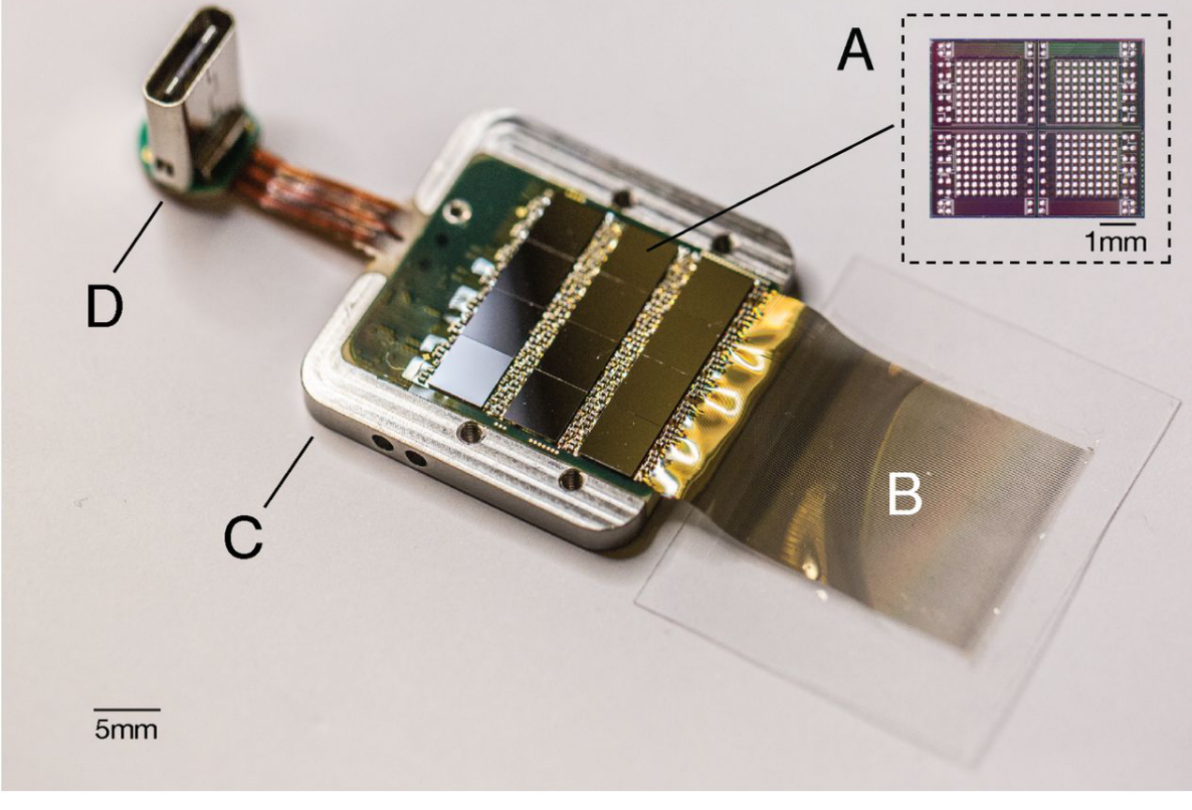
Table 2. System A employs the current-generation Neuralink ASIC, while System B uses an earlier revision with comparable functionality but poorer performance